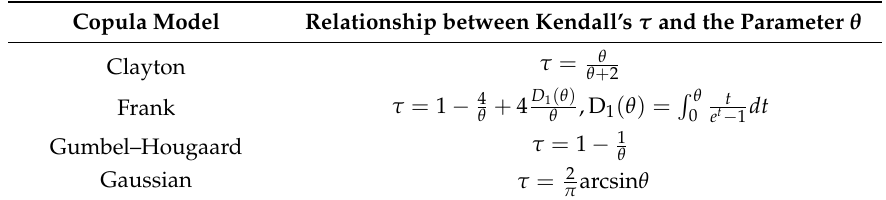
Table 2. Relationship between the Kendall’s τ and the parameter θ